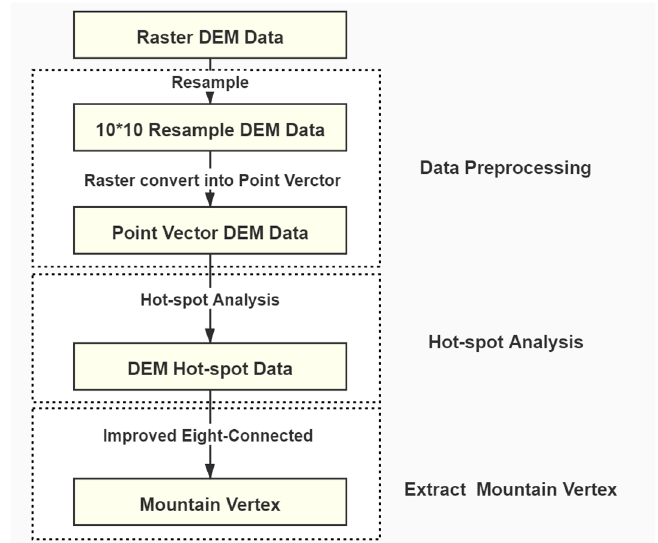
Figure 2. The overall technical route.